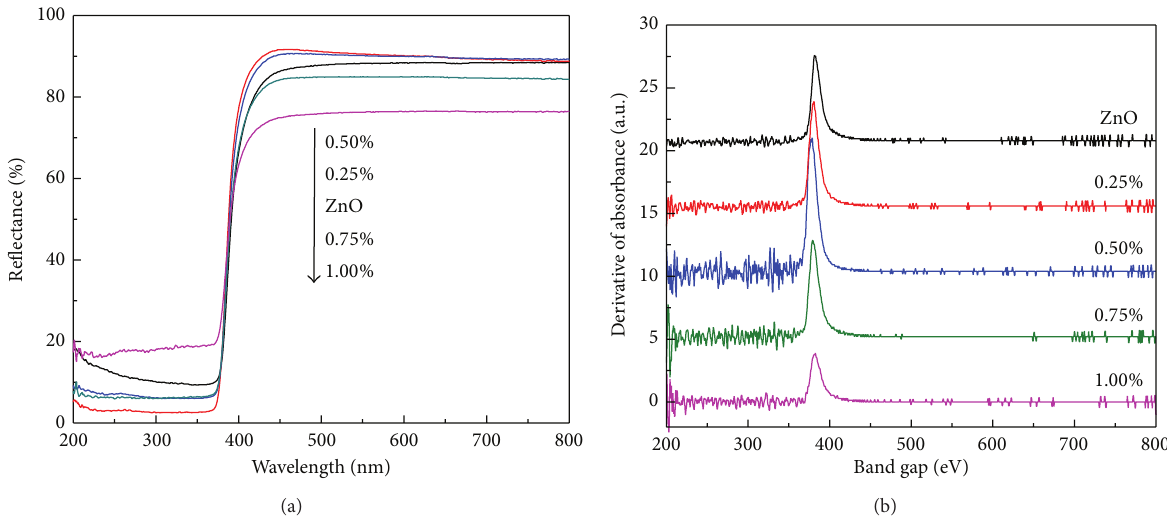
Figure 3: UV-visible diffuse reflectance spectrum of Y 2 O 3 -ZnO complex oxides contained different Y 2 O 3 content (a) and the corresponding first derivative of the spectrum